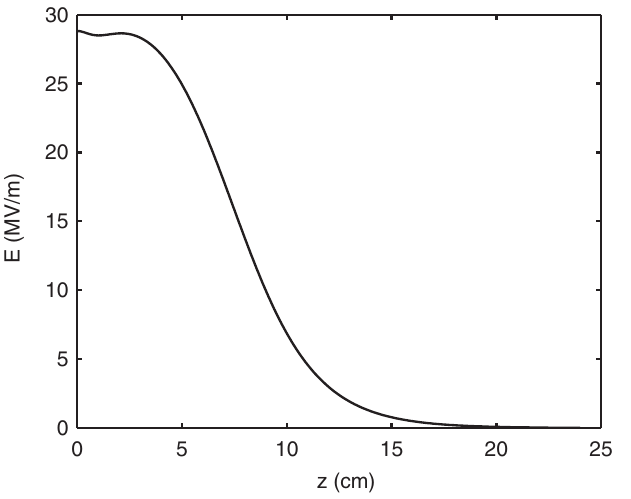
FIG. 4. (Color) The effective potential energy (red curve) and the total effective energy (green and blue curves) of H þ 2 ions in the BNL 1 = 2 -cell SRF gun. The green and blue curves, respec- tively, show the total energy of ions with the effective velocity _ x 0 pointing towards the cathode and away from the cathode. Ions with an initial velocity directed towards the cathode and whose total energy is higher than the maximum potential energy will reach the cathode.